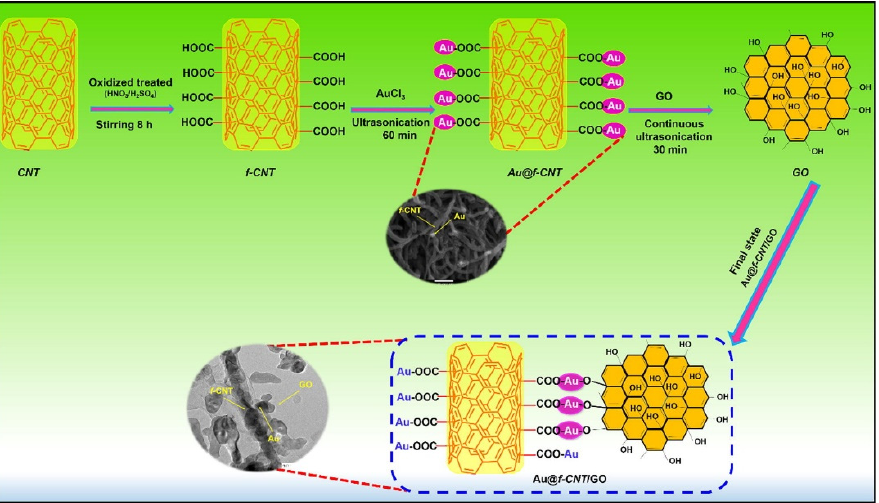
Figure 6. Overall synthesis of Au@f-CNT/GO hybrid nanocomposite via ultrasonication. Reproduced from reference [135] with permission from Elsevier, copyright 2021.